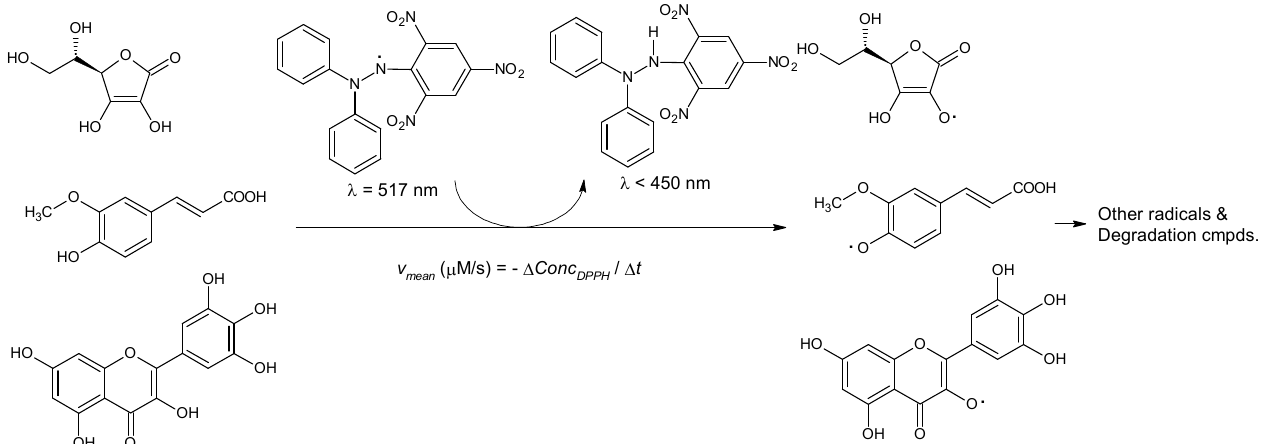
Figure 2. Schematic radical reaction between DPPH · and antioxidant compounds from papaya fruit extracts (ascorbic acid, ferulic acid, and myricetin).